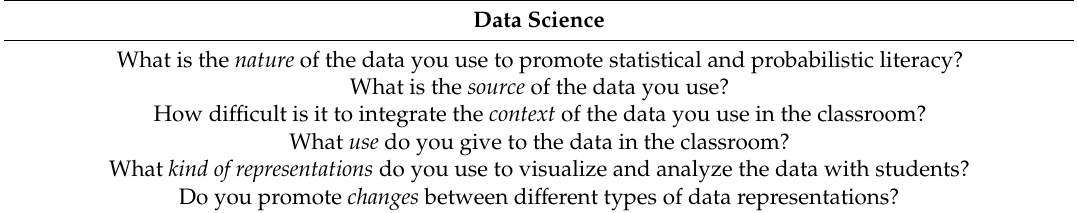
Table 1. The questions that were used during the group